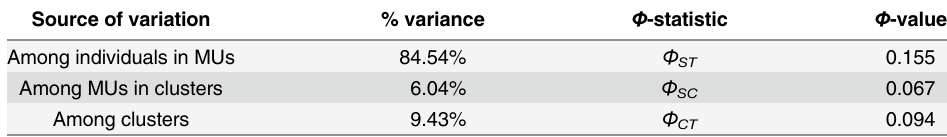
Table 4. Hierarchical analysis of molecular variance (AMOVA) for mitochondrial DNA among manage- ment units within the six genetic clusters identified in this paper and shown in Table 2. Note that many management units (incl. the entire Norwegian Bay cluster) were excluded entirely from this AMOVA because of inadequate sampling. Because we lacked sample location information for downloaded haplotypes, we were unable to split Davis Strait or the Laptev Sea into northern/southern or eastern/western samples; there- fore, these MUs were removed for this calculation in addition to the MUs that were removed for low sample sizes in Table